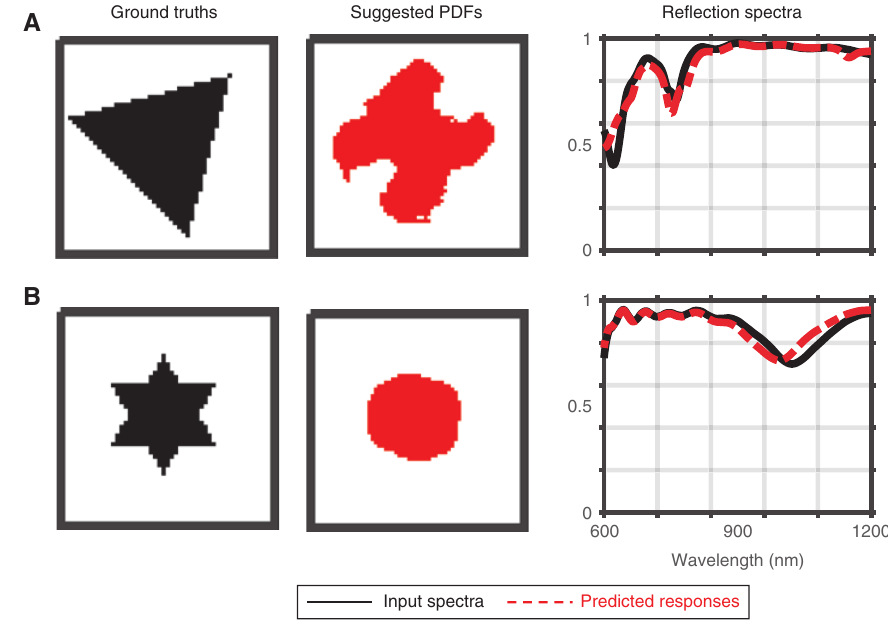
Figure 4: cDCGAN suggestion results of completely new structures. New structures of (A) triangle and (B) star shape antennae, whose shapes have never been used in training, are used. The first columns are the target of desired designs and the second columns are PDFs suggested by cDCGAN. The last columns show the reflection spectra of the input (black solid lines) and the simulation result obtained from the suggested designs (red dotted lines),